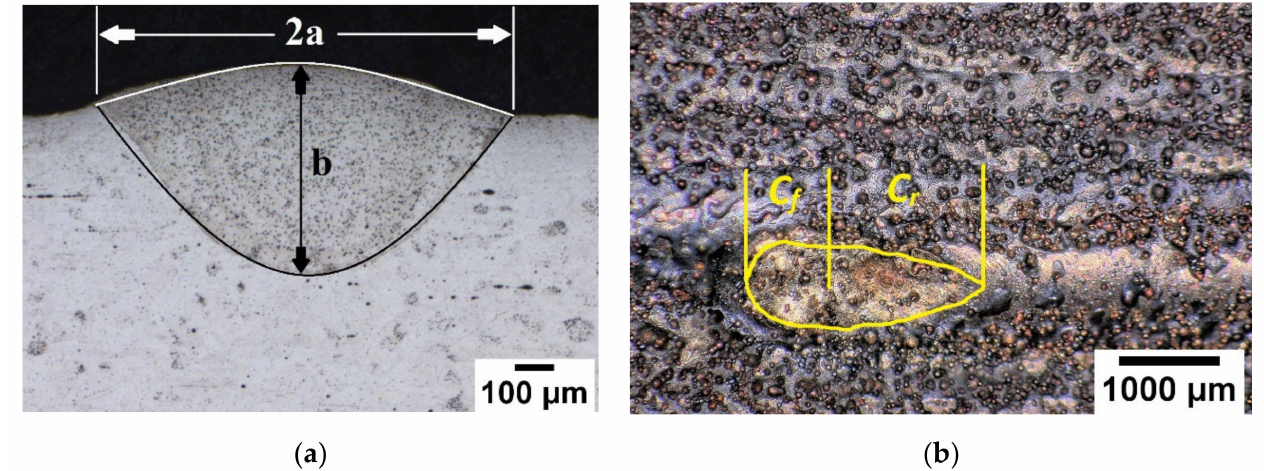
Figure 12. ( a ) Transverse section of the melt pool from optical microscope; ( b ) Front and rear sections based on the end crater geometry.